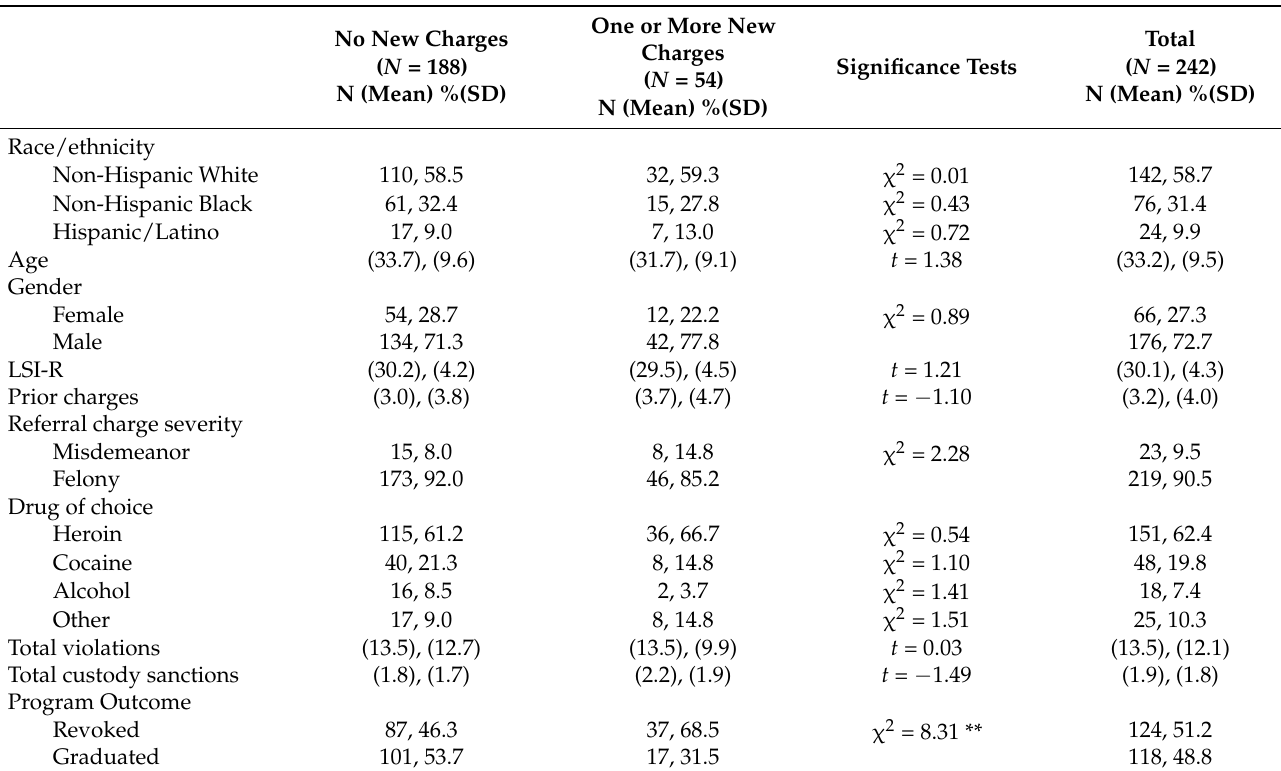
Table 7. Descriptive Statistics for Likelihood of Recidivism ( N =